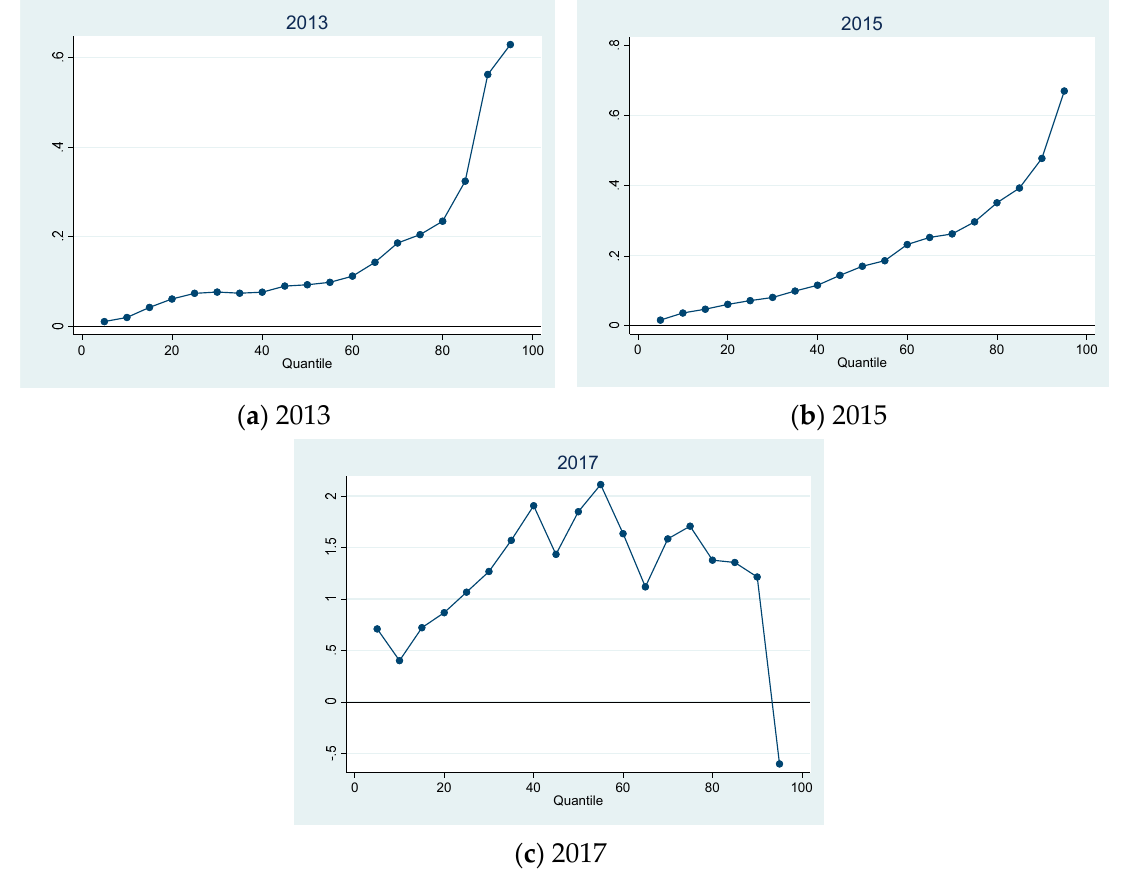
Figure 2. The quantile effect of financial cognitive level on rural household income in different years that ( a – c ) describe the situation in 2013, 2015, and 2017, respectively.